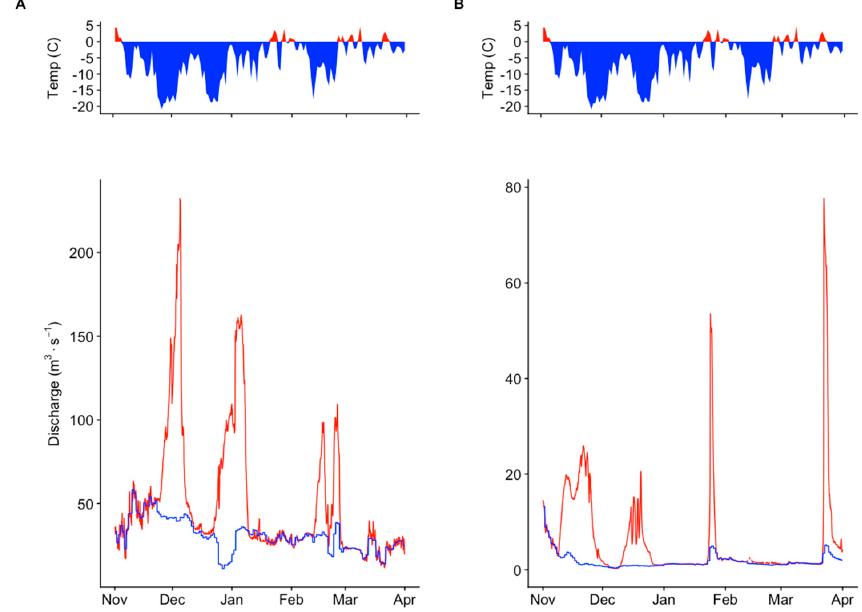
Figure 3. Comparison of flow records from the regulated Syrstad gauge ( A ) and the unregulated Hugdal Bru gauge ( B ) for the winter 2010/2011.